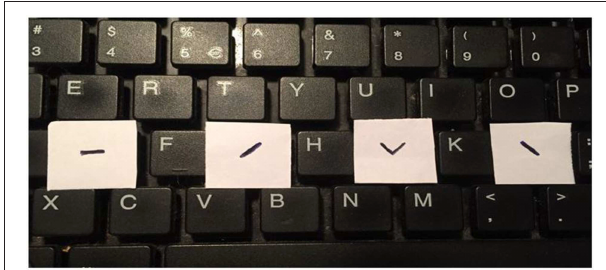
FIGURE 2 | Picture of the designated keys with tone symbols.